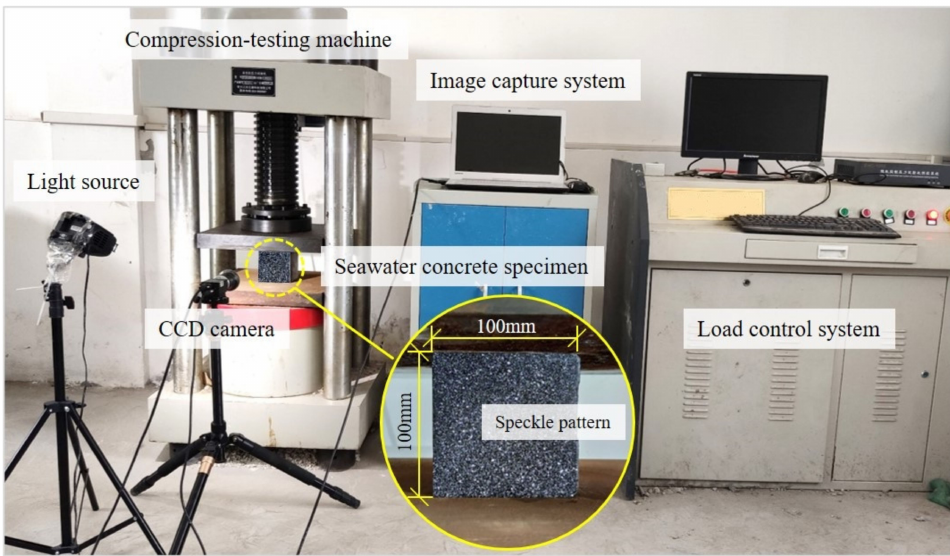
Figure 2. Full-field optical deformation measurement system consisted of uniaxial compressive loading and optical image capturing setup for the seawater concrete.